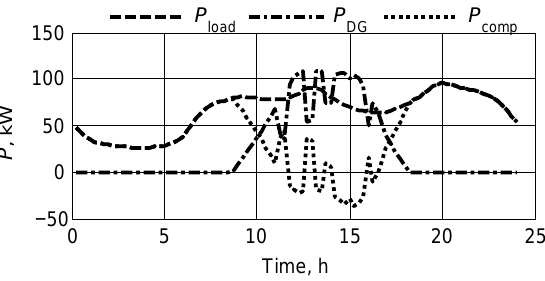
Fig. 8. Prediction curve for P load , P DG and the resulting P comp (scenario